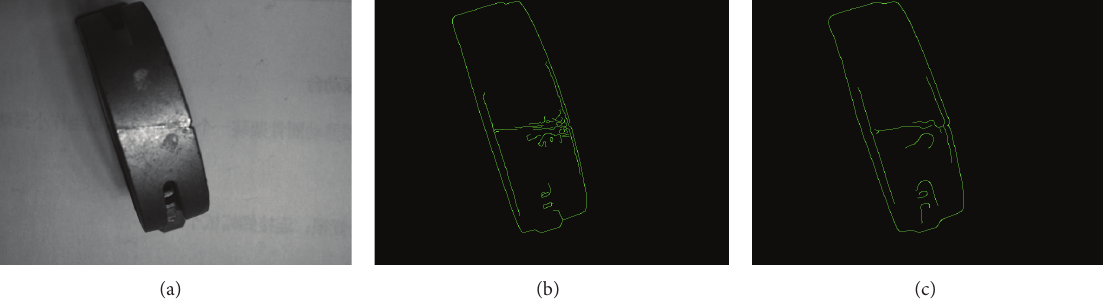
Figure 11: The original image (a), the output image based on original PCNN segmentation (b), and the output image based on our PCNN segmentation (c).